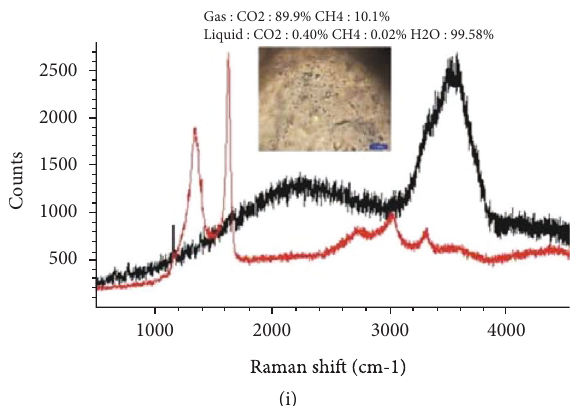
Figure 7: Laser Raman spectrogram of fl uid inclusions in sandstone reservoir in the study area. (a) Qingtan 2 well, Shanxi Group, 4722.80m; (b) Qingtan 2 well, Shanxi Group, 4722.80m; (c) Qingtan 2 well, Shanxi Group, 4728.08m; (d) Lian 1 well, Shihezi Group, 3424.26m; (e) Lian1 well, Shihezi Group, 3424.26m; (f) He 3 well, Shihezi Group, 4073.09 m; (g) He 3 well, He 8 section, 4081.68m; (h) Zitan 1 well, Shihezi Group, 3736.19m; (i) Zitan 1 well, Shihezi Group,